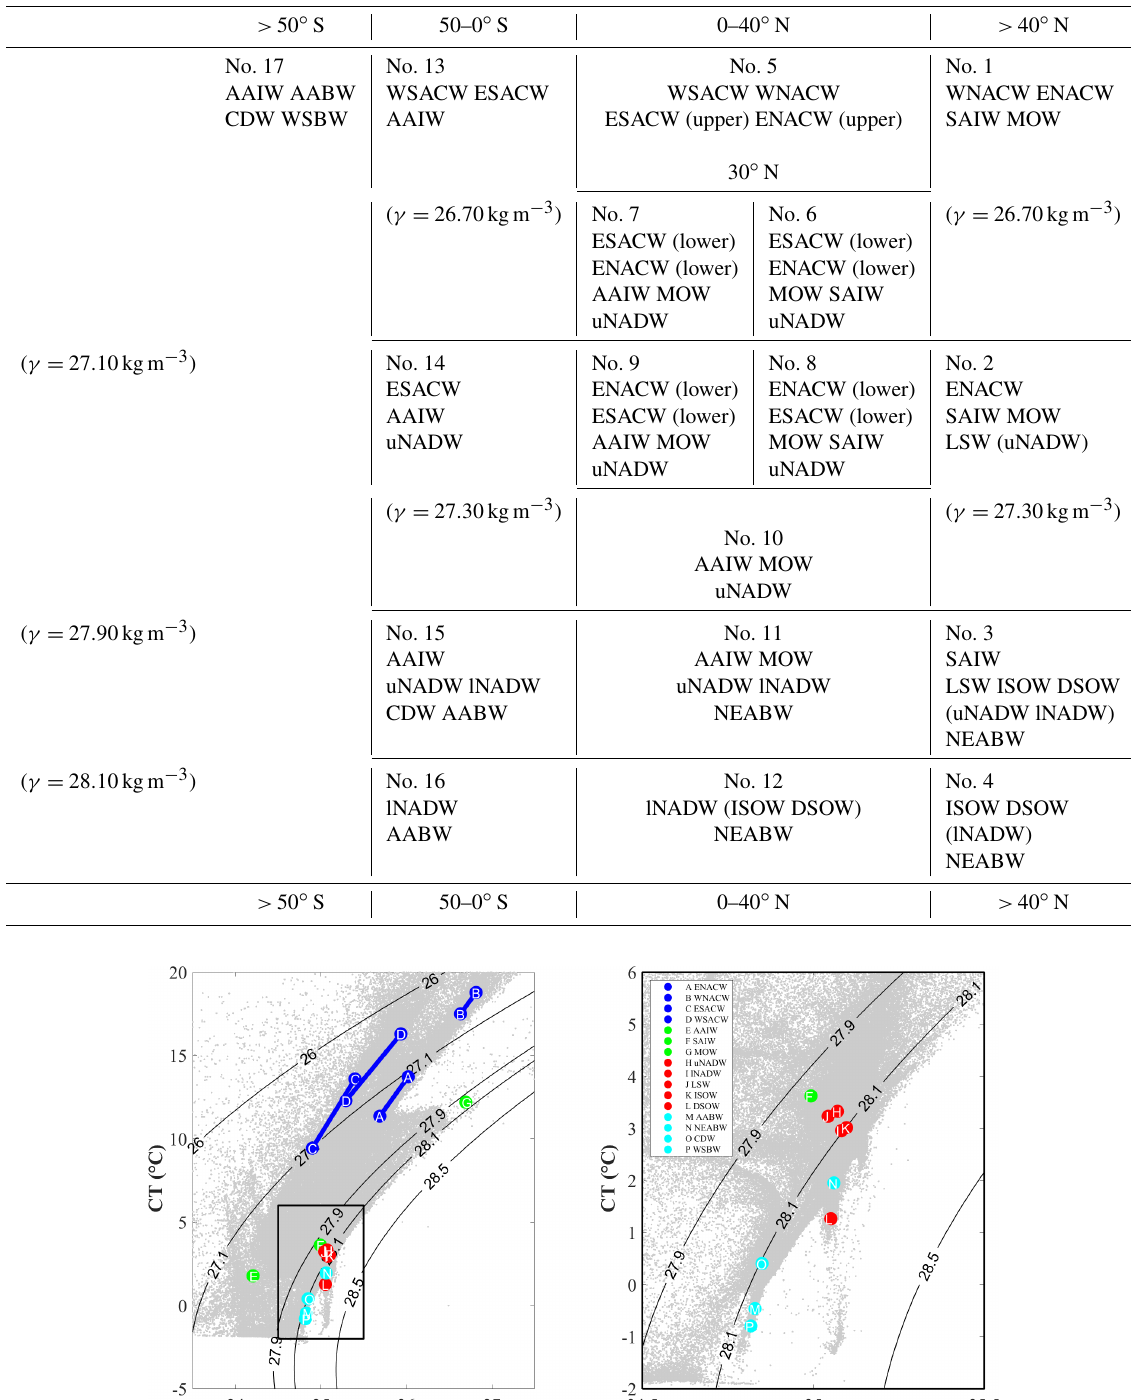
Table 1. Schematic of the selection criteria for the OMP analysis (runs) in this study.